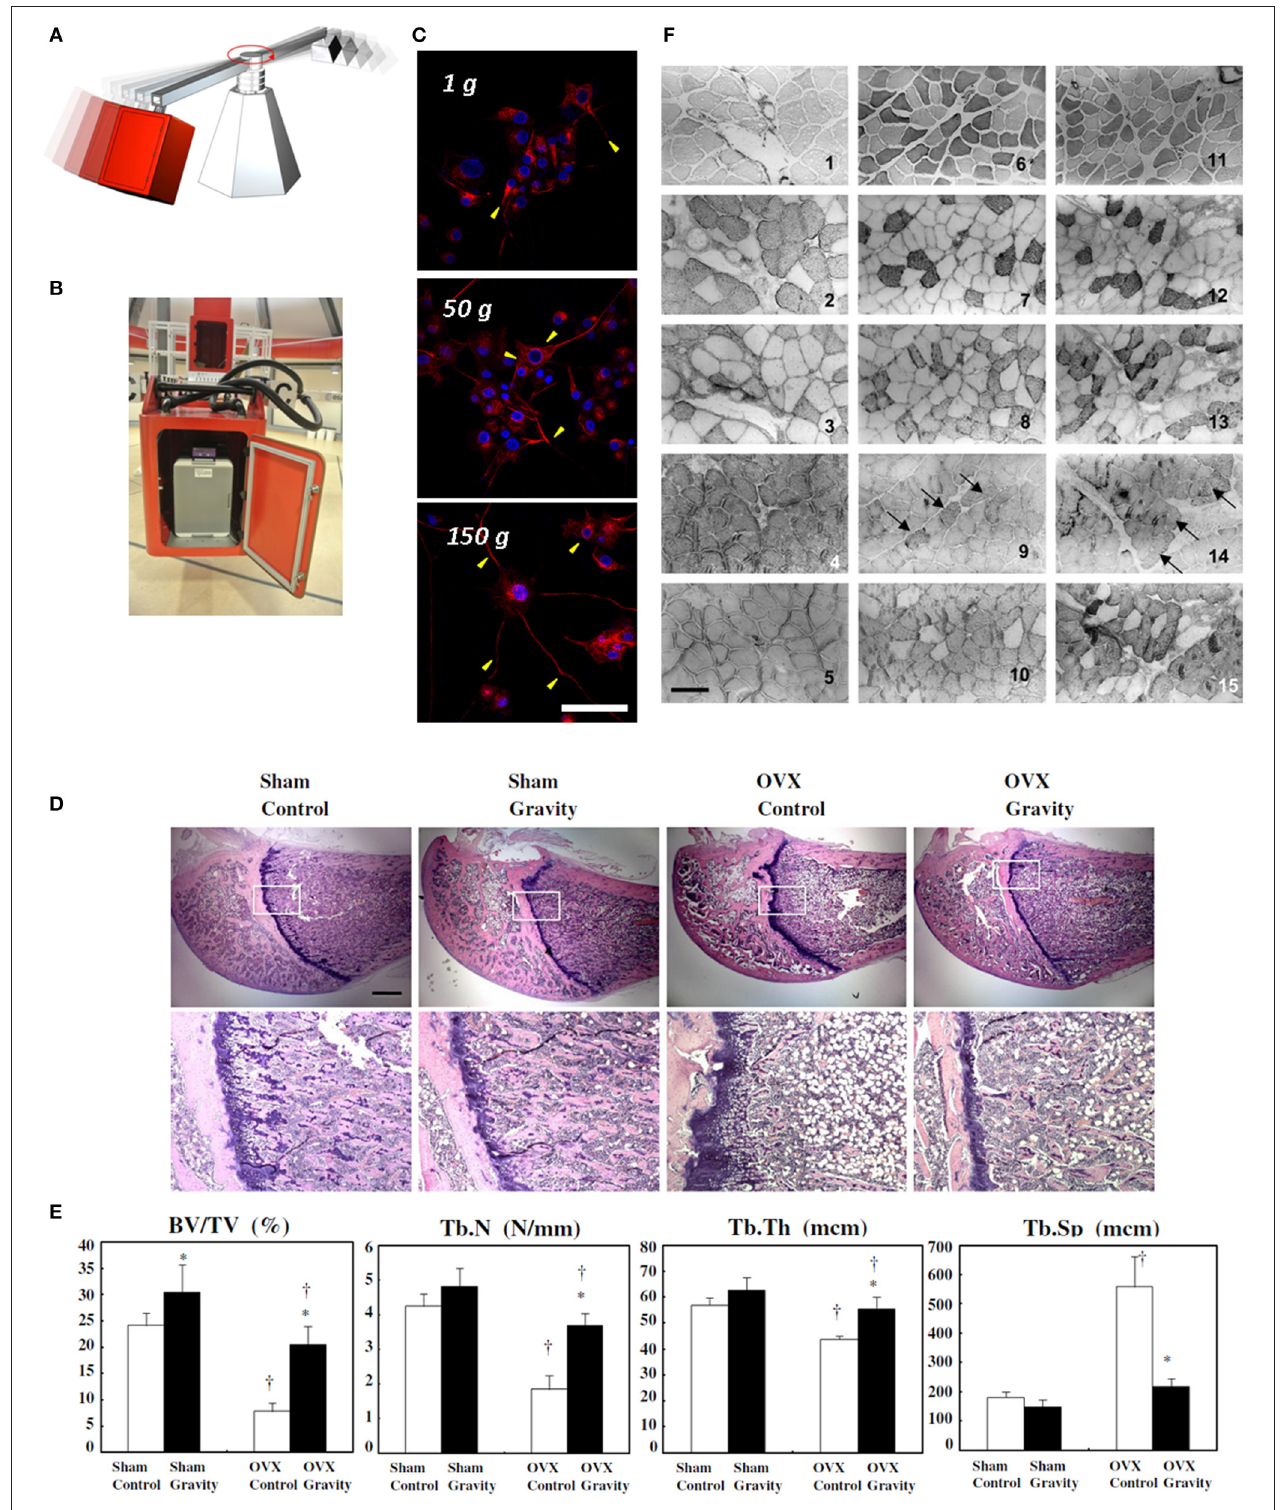
FIGURE 1 | Hypergravity experiments on cell cultures. Pictorial representation of a large diameter centrifuge, exploited for hypergravity investigations (A) and a gondola of the large diameter centrifuge at the European Space Agency (B) . Confocal fluorescence microscopy images of 72h pre-differentiated PC12 neuron-like cells exposed to different gravity levels (1, 50, and 150g for 1h), and fixed 48h post-stimulus, showing different localization of the differentiation marker